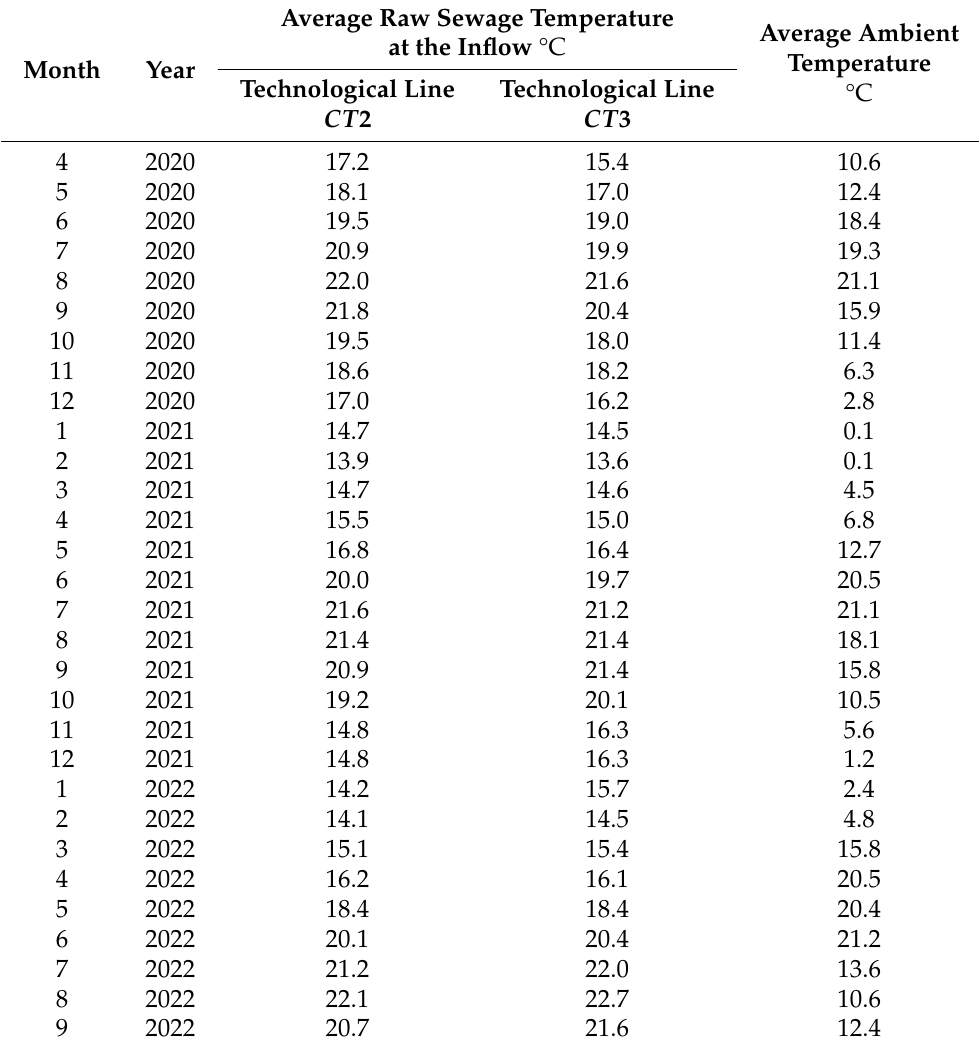
Table 1. Comparison of raw sewage temperature values in technological lines CT 2 and CT 3 with ambient outdoor